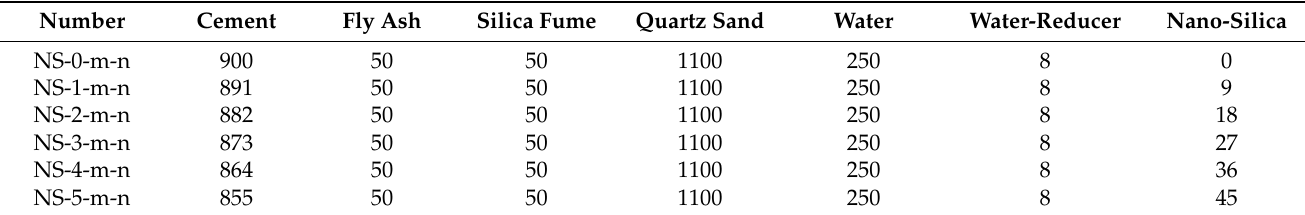
Table 3. Mix proportion of high performance concrete